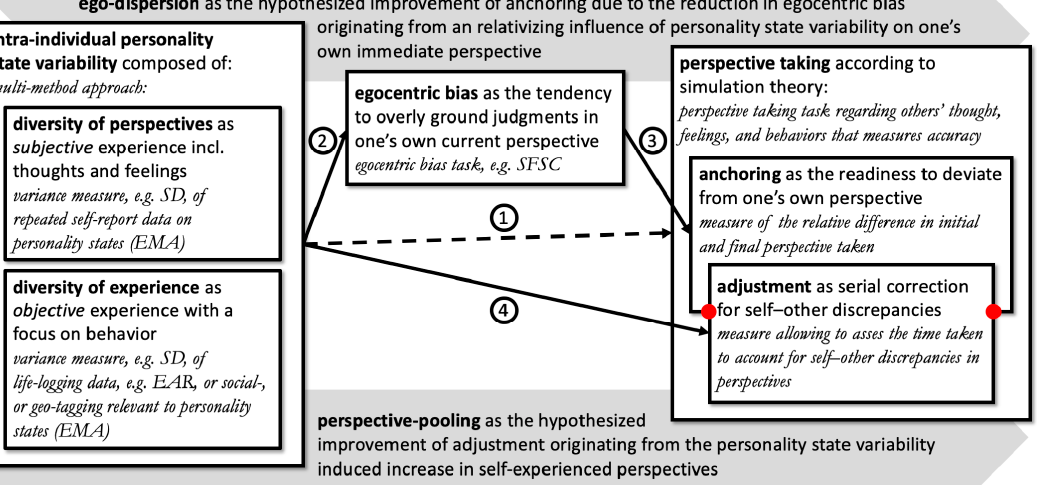
Figure 3. Proposed relation of state variability and perspective taking. Format : constructs are in bold, construct specifying notes in roman, and construct operationalizations in italic. Abbreviations : EAR—electronically activated recorder; EMA—ecological momentary assessment; SD—standard deviation; SFSC—self-focus sentence completion task. Numbers : Compare Section 3.3, summarizing hypotheses (1) to (4). We propose a two-fold positive relation between state variability and perspective taking. Ego-dispersion describes the effect of state variability on anchoring mediated by egocentric bias ((2) and (3)). Perspective-pooling describes a direct effect of state variability on the adjustment process (4). Taken together, this should explain how state variability allows for more accurate perspective taking (1). The solid arrows specify the two routes hypothesized by our model, while the dashed arrow specifies the overall effect if the relation of state variability on perspective taking is considered without the details of our model. Furthermore, the dashed arrow may specify the direct effects of state variability on perspective taking not considered by our model.